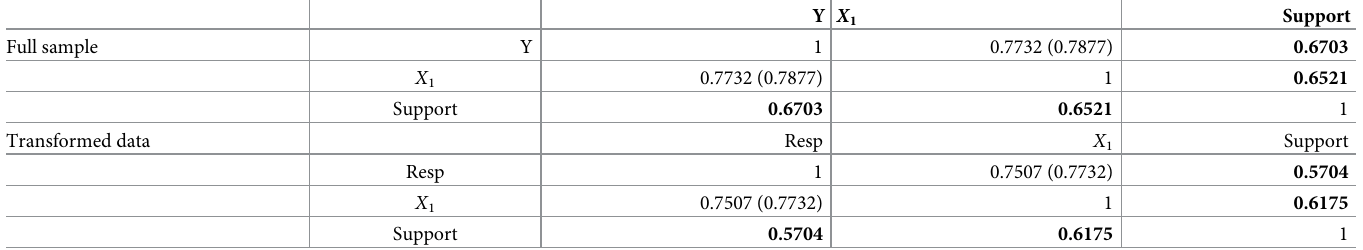
Table 2. Measure association of variables in the full sample and transformed data. A Pearson correlation coefficient is for {Y, X 1 } or {Resp, X 1 }, and Spearman rank correlation coefficient is in (). A point-biserial correlation coefficient appears in boldface.